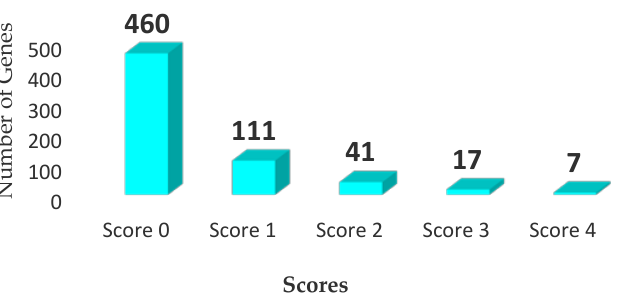
Score on each of Functional Annotations